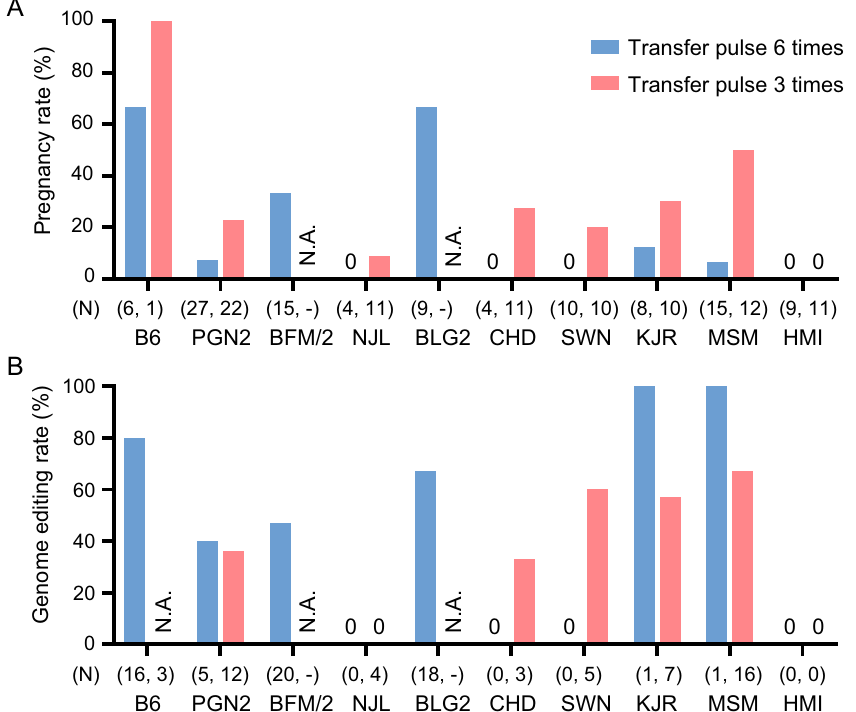
Figure 3. Comparison of efficiencies between the methodologies of 6 times transfer pulse(TP:6) and 3 times transfer pulse (TP:3) in the i -GONAD experiments. N; number of pups obtained in the i -GONAD experiments in each strain. ( A ) Overview of the pregnancy rates between TP:6 and TP:3. N.A., not analyzed. ( B ) Efficiencies of genome editing upon application of TP:6 and TP:3. The efficiencies were calculated by dividing the number of genome-edited pups by the number of all the sampled pups in each strain. The B6 strain and seven wild strains that displayed low pregnancy rates (< 20%) were further examined with the TP:3 condition.